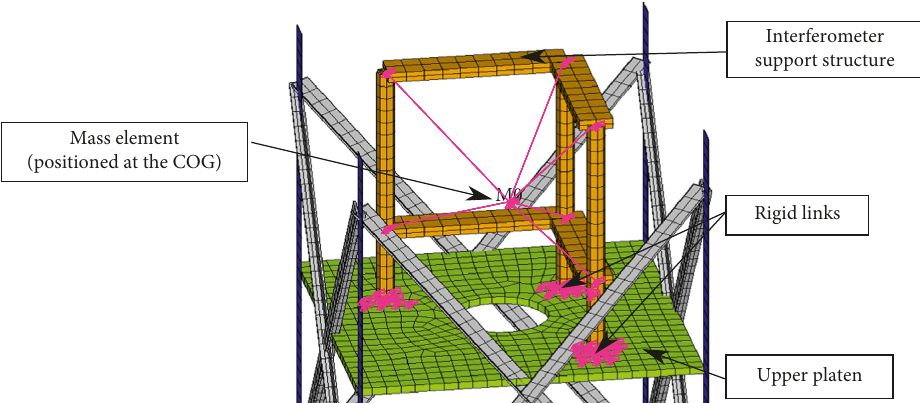
Figure 3: Upper platen and the interferometer support structure (ISS). In pink, rigid links can be